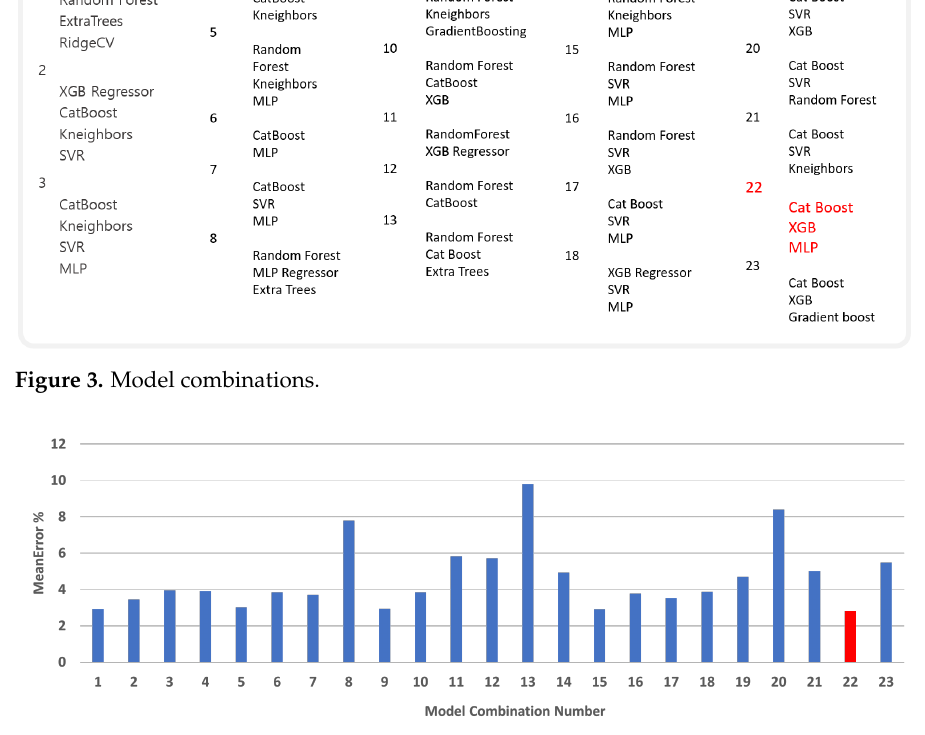
Figure 4. Mean error comparison of model